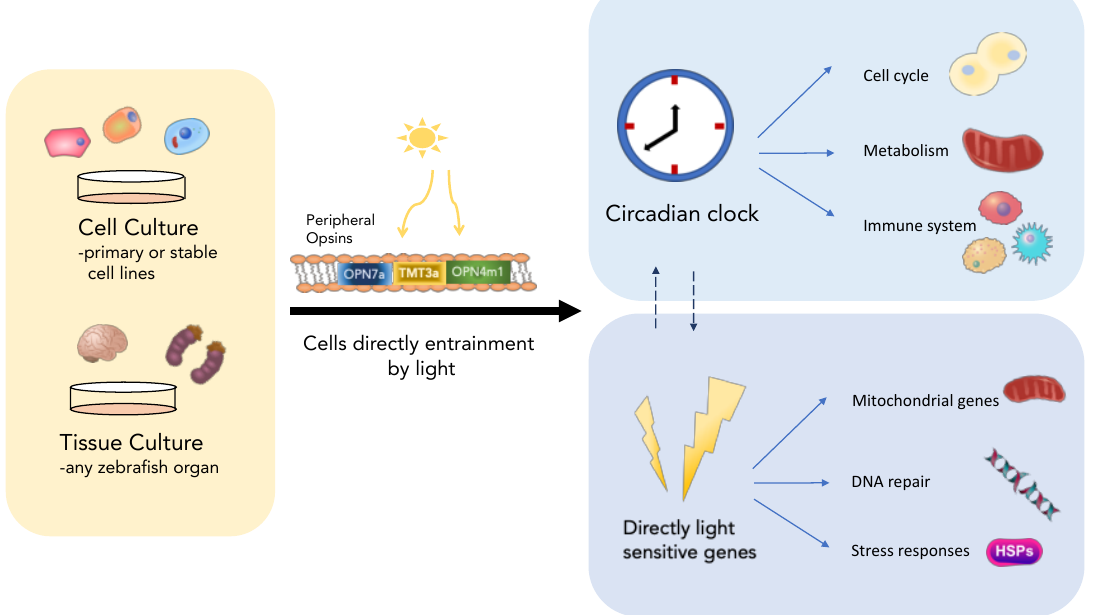
Figure 1. Zebrafish tissues are rhythmic and directly light-responsive. All zebrafish cell types and tissue/organs examined to date are directly light-responsive and do not require a centralised photosensitive structure to turn on light-induced transcription. Cells and organs can be entrained directly by light stimuli through the use of visual and non-visual peripheral opsins. The light signal starts transcription of light-sensitive genes, such as stress responses and DNA repair, as well as the clock genes per2 and cry1a , which sets the circadian clock. The peripherally entrained clock in turn regulates a plethora of downstream cellular processes